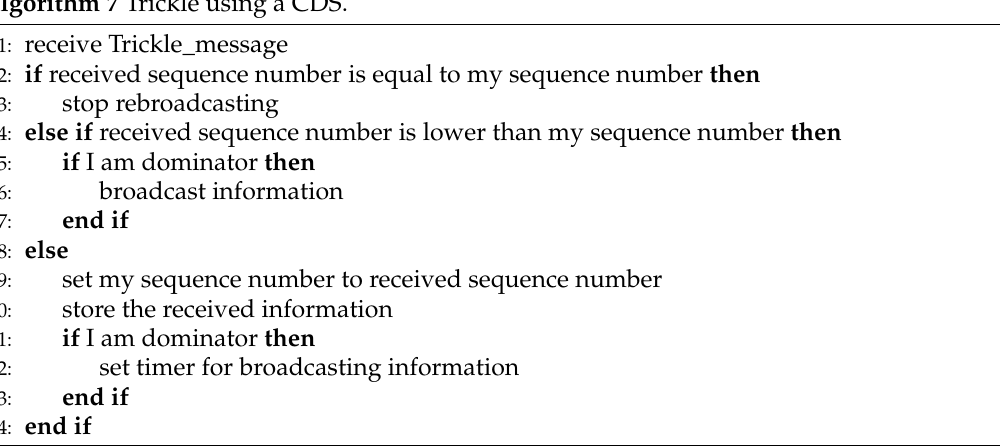
Algorithm 7 Trickle using a